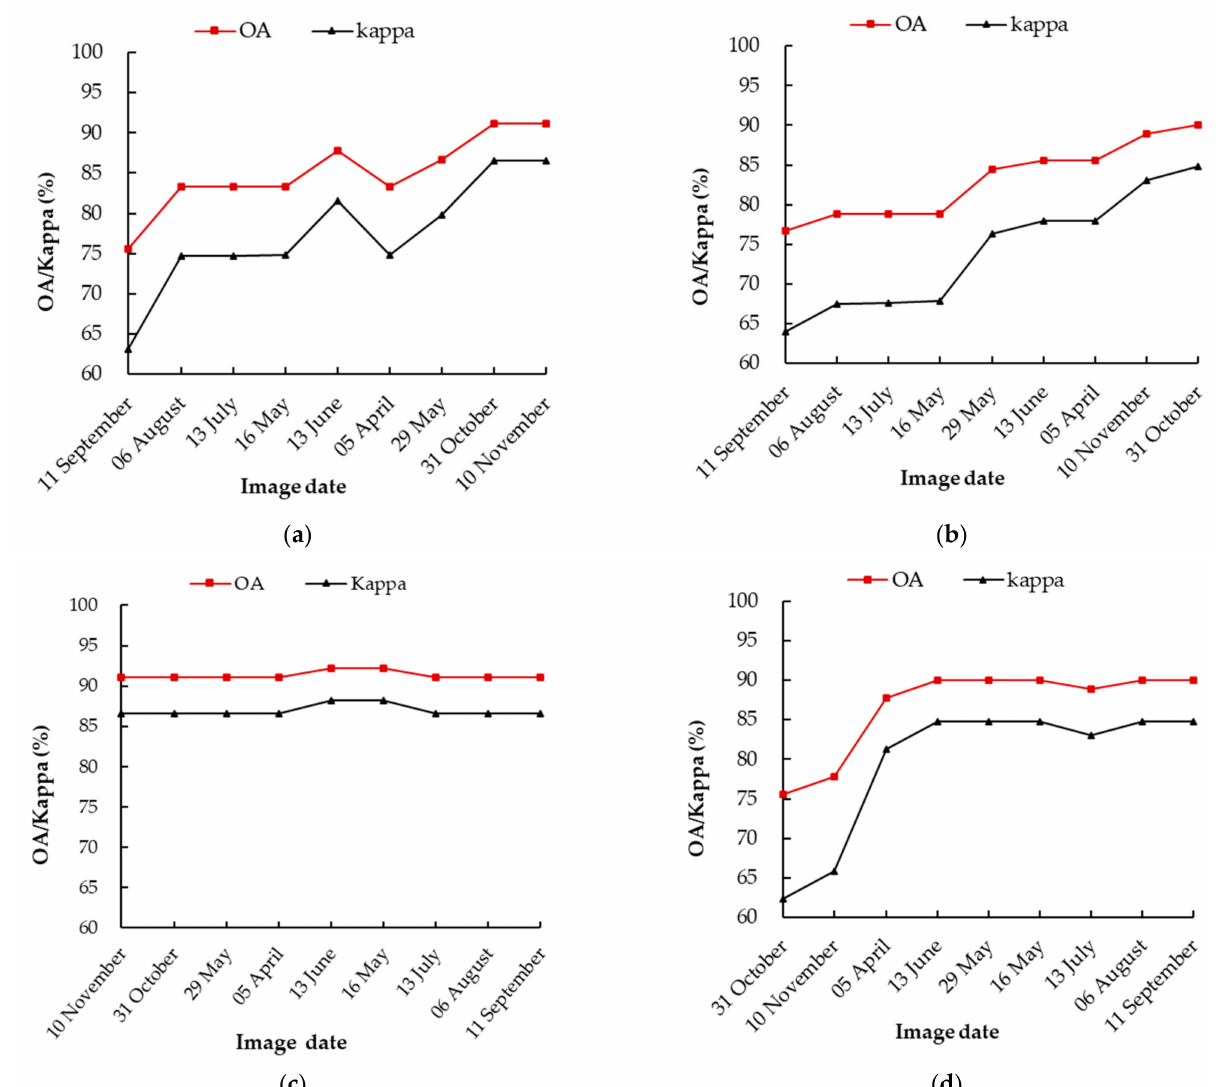
Figure 10. The changes in overall accuracy (OA) and Kappa coefficient (Kappa) as the images were added. ( a ) Model 1, the images were gradually added from low to high of date importance; ( b ) Model 2, the images were gradually added from low to high of date importance; ( c ) Model 1, the image were gradually added from high to low of date importance; ( d ) Model 2, the image were gradually added from high to low of date